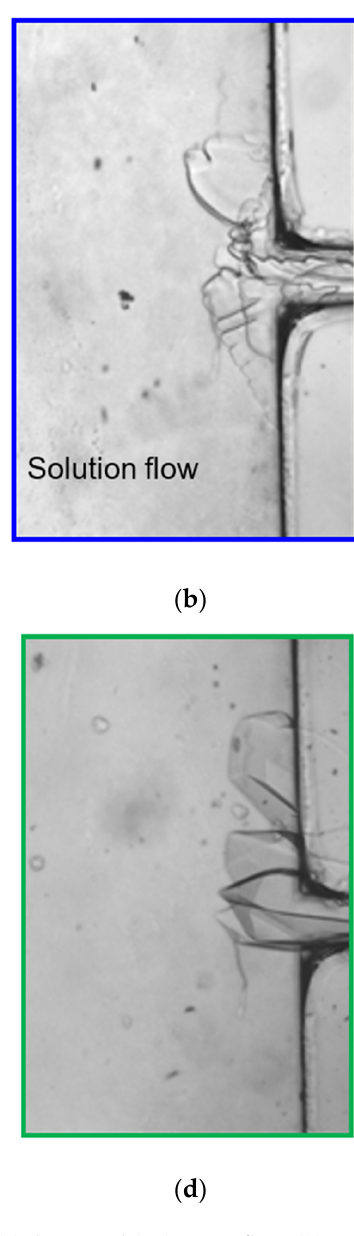
Figure 3. Typical images of ice/liquid flow interfaces in early stages: ( a ) deionized (DI) water flow, ( b ) salt-solution flow, ( c ) HPLC6-solution flow, and ( d ) mixed-solution flow.